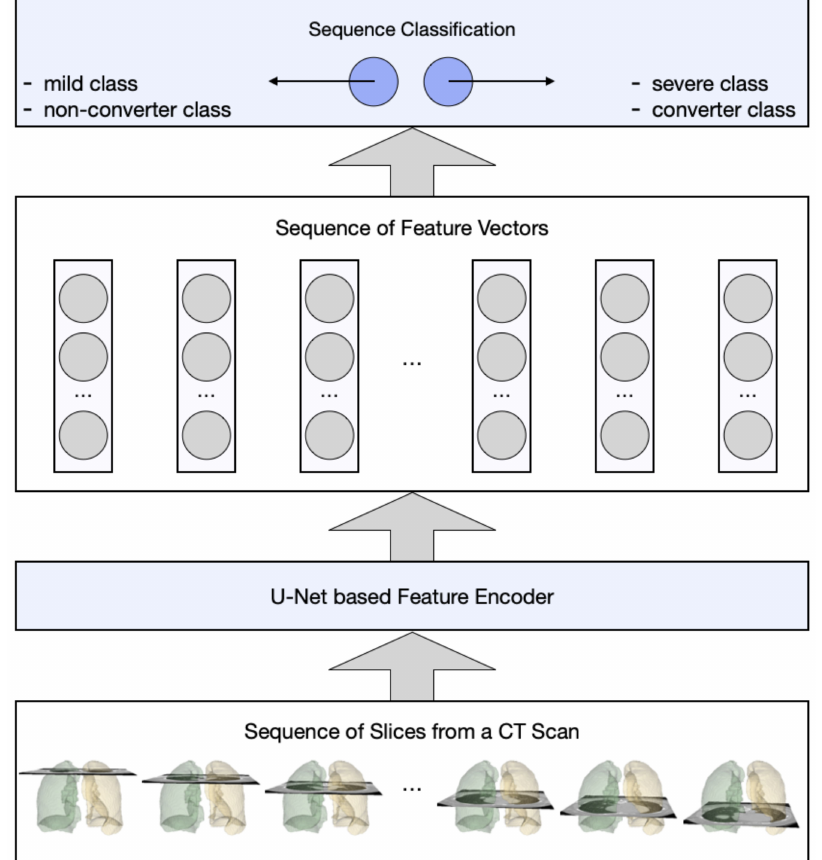
Figure 2. An overview of the proposed LesionEncoder